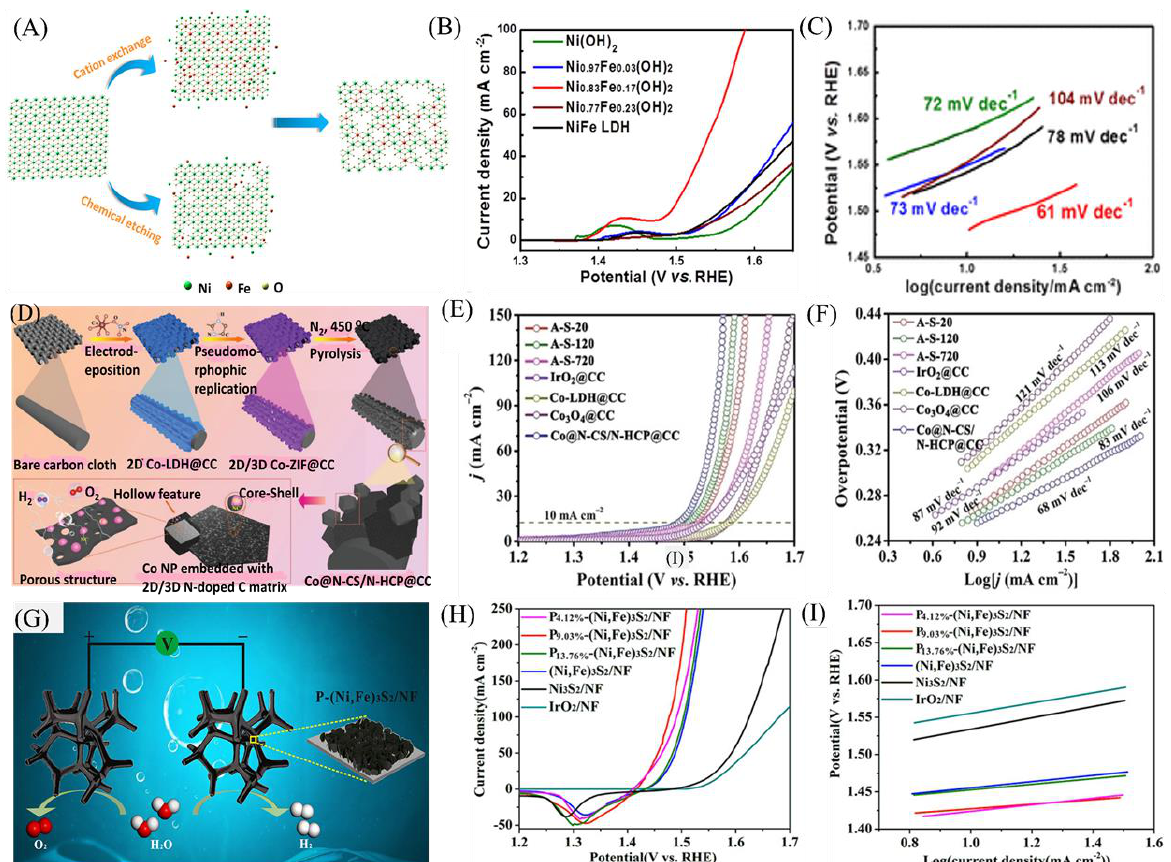
Figure 7. ( A ) Schematic illustration of the preparation of Fe-doped Ni (OH) 2 nanosheets. ( B ) LSV curves of Ni 0.83 Fe 0.17 (OH) 2 nanosheets. ( C ) Tafel slopes of Ni 0.83 Fe 0.17 (OH) 2 nanosheets. Reproduced with permission from [114]. American Chemical Society, 2018. ( D ) Schematic illustration of the synthesis of Co@N-CS/N-HCP@CC composite. ( E ) LSV curves. ( F ) Corresponding Tafel plots. Reproduced with permission from [126]. WILEY-VCH Verlag GmbH & Co. KGaA, Weinheim, 2019. ( G ) Illustration of water splitting on the surface of P-(Ni, Fe)3S2/NF. ( H ) LSV curves. ( I ) Corresponding Tafel plots. Reproduced with permission from [128]. American Chemical Society,